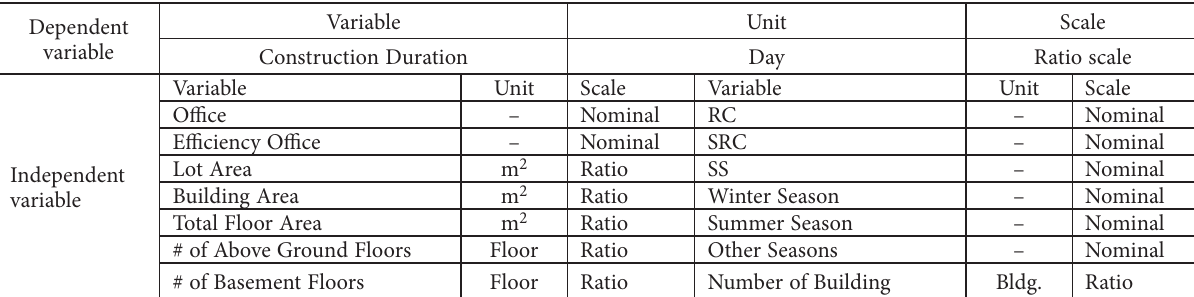
Table 6. Establishing dependent and independent variables for multiple linear regression analysis